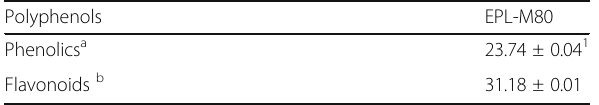
Table 2 Polyphenol contents of EPL-M80 Polyphenols